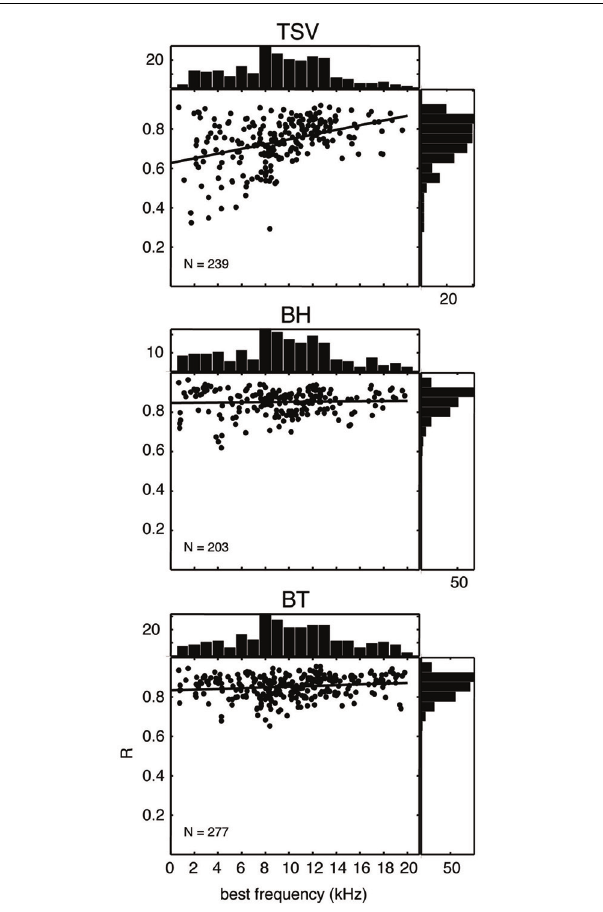
FIGURE 10 | Scatter plots for correlation values versus best frequency. The peak correlation values ( R ) is plotted for ICC sites with different best frequencies for all three vocalizations from 10 animals.The histogram on top of each plot shows the distribution of best frequencies across all the ICC sites, while the histogram on the right shows the distribution of correlation values.The solid line in each plot corresponds to the least-squares fit to the data. N denotes number of total ICC sites for each vocalization.